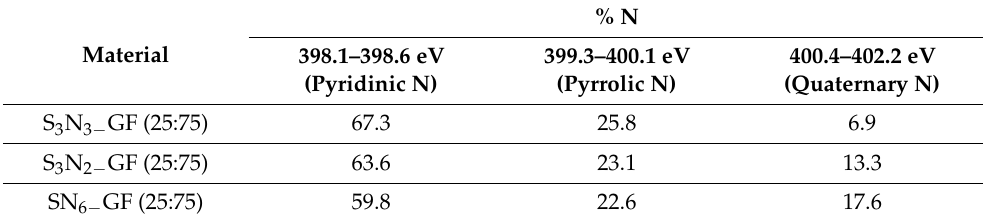
Table 3. Relative atomic percentages of nitrogen in the N1s